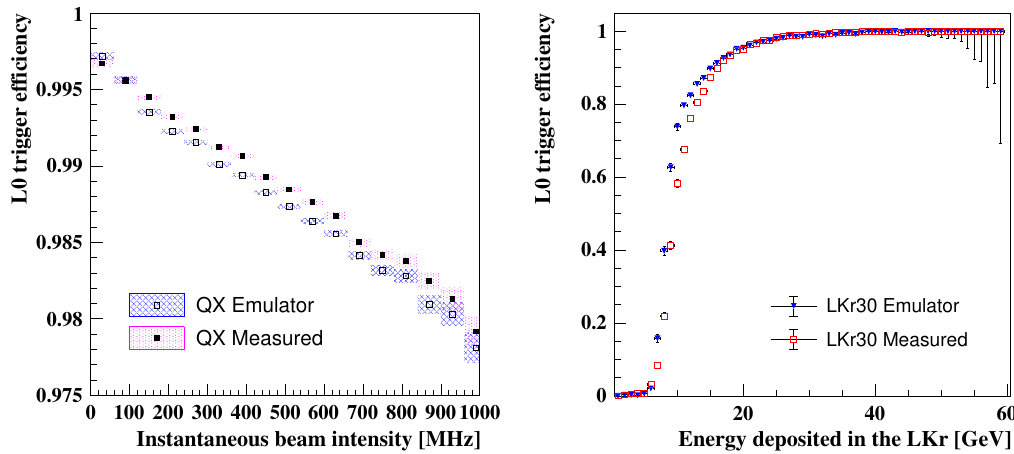
Figure 12. Efficiencies of the L0 trigger conditions QX (left) and LKr30 (right) measured using K + → π + π + π − events collected via the control trigger line, and simulated using the trigger emula- tor on the same data. The hatched areas indicate the statistical uncertainties of the